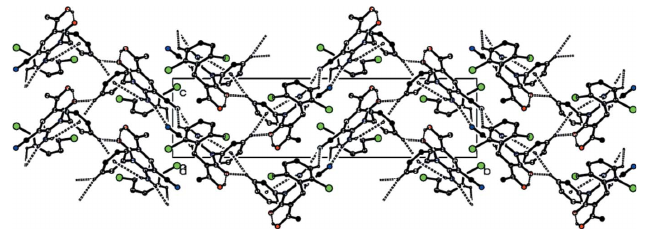
Figure 3 Aview down the a axis of the crystal packing of the title compound based on the intermolecular interactions shown in Fig.